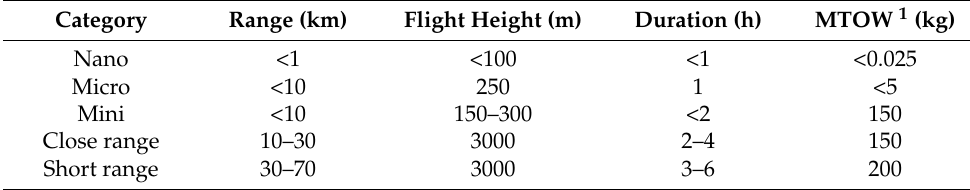
Table 4. Drone Classification